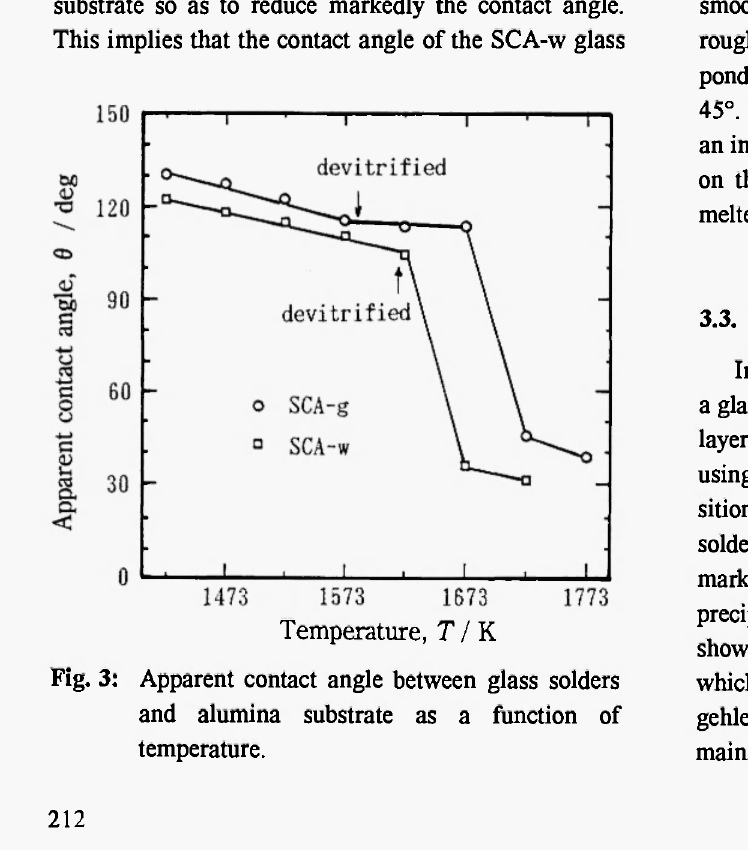
Fig. 3: Apparent contact angle between glass solders and alumina substrate as a function of